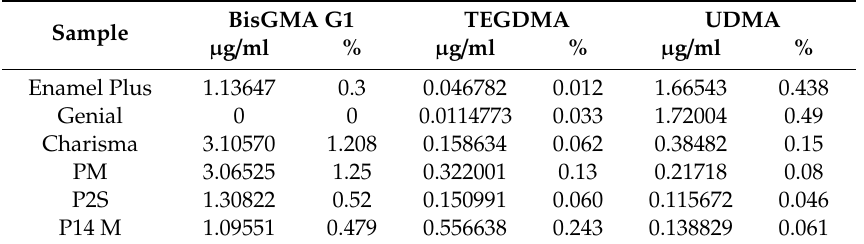
Table 3. Quantities and rates of the extracted residual monomers in chloroform reported to 1